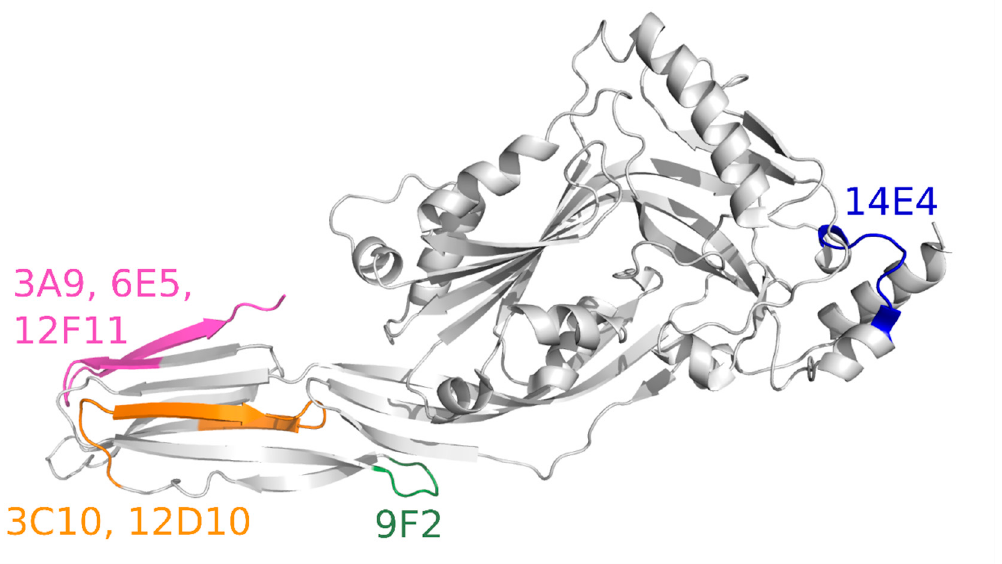
Figure 4. The regions of PLY necessary for recognition of MAb 14E4 (aa 212–220, coloured in blue), 9F2 (aa 384–389, coloured in green), MAbs 3C10, 12D10 (aa 403–423, coloured in orange), MAbs 3A9, 6E5, 12F11 (aa 454–471, coloured in pink) on PDB structure 5AOD.